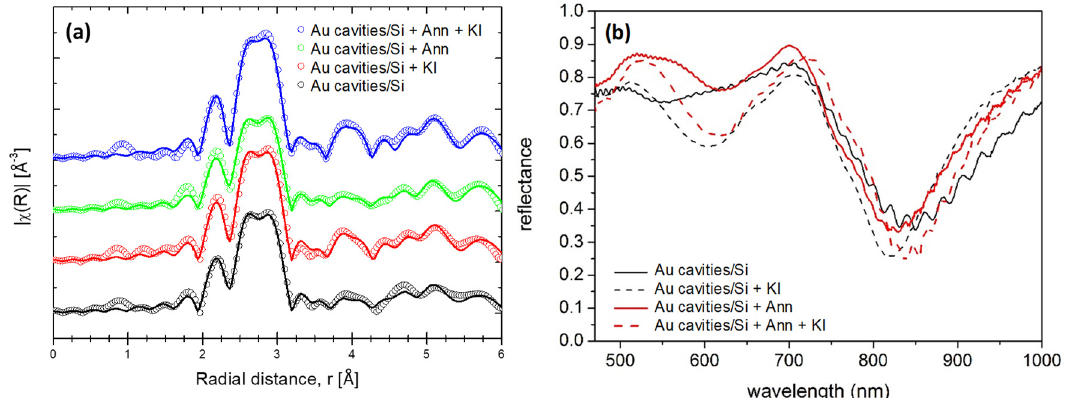
Figure 4. ( a ) Radial distribution functions for the Au films deposited through the colloidal mask on Si before and after post-processing by KI immersion for 1 min (KI), after annealing at 300 ◦ C (Ann) and after both annealing and KI etching (Ann + KI). ( b ) Reflectance spectra of the Au cavity films deposited on SiO 2 before and after post-processing in identical conditions as described in ( a